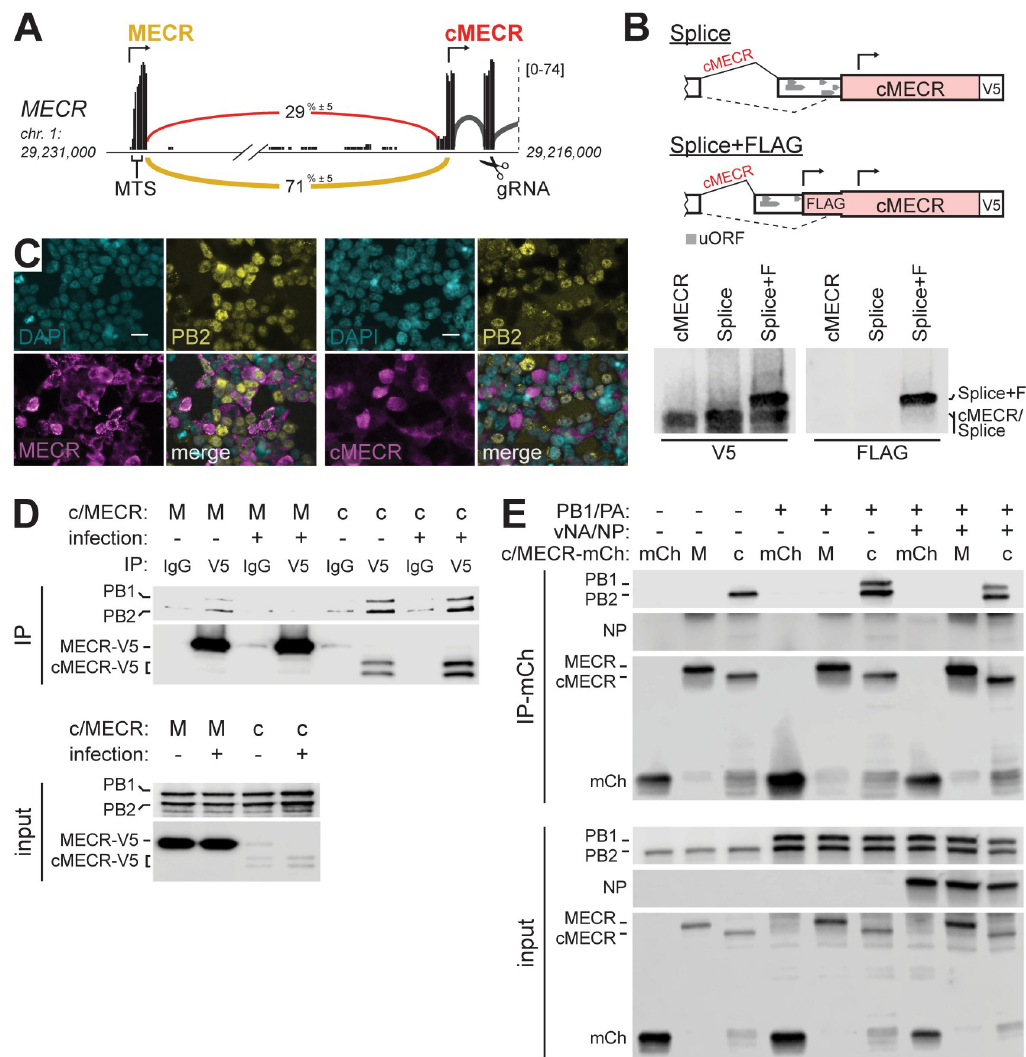
Fig 5. The alternative splice variant cMECR binds viral polymerase subunit PB2. (A) Sashimi plot of RNA-seq data from A549 cells showing alternative 3 0 splice site utilized by transcripts that do not translate the MTS in exon 1. Numbers embedded in yellow (MECR) and red (cMECR) curves indicate percentage of each splicing event as a total of all exon-joining reads. Arrows indicate translational start sites and gRNA denotes region targeted in CRISPR-Cas9 editing. (B) Splicing reporters were constructed as diagrammed and expressed in 293T cells with cMECR cDNA as a control. Proteins were detected by western blot. (C) 293T cells expressing MECR or cMECR were infected with influenza PB2-FLAG virus (MOI, 3; 8 h). Subcellular localization of PB2, MECR, or cMECR were determined by immunofluorescence microscopy. Scale bars, 20 μ m. (D-E) The viral polymerase subunit PB2 associates with cMECR during infection. (D) PA, PB1-FLAG, PB2-FLAG, and V5-tagged MECR or cMECR were expressed in 293T cells. Where indicated, cells were also infected with WSN (MOI, 10; 6 h). Cells were lysed and immunoprecipitated with anti-V5 antibody or IgG controls. Proteins were detected by western blot. (E) mCh, MECR M77L- mCh, or cMECR-mCh were coexpressed with PB2-FLAG in the absence or presence of PB1-FLAG, PA, NP, and vNA. Cells were lysed and immunoprecipitated with mCh affinity resin. Proteins were detected by western blot. Uncropped images can be found in the Supporting information file as S1 Raw Images. cMECR, cytoplasmic MECR; IgG, immunoglobulin G; IP, immunoprecipitation; mCh, mCherry; MECR, mitochondrial enoyl CoA-reductase; MTS, mitochondrial targeting signal; NP, nucleoprotein; vNA, NA viral